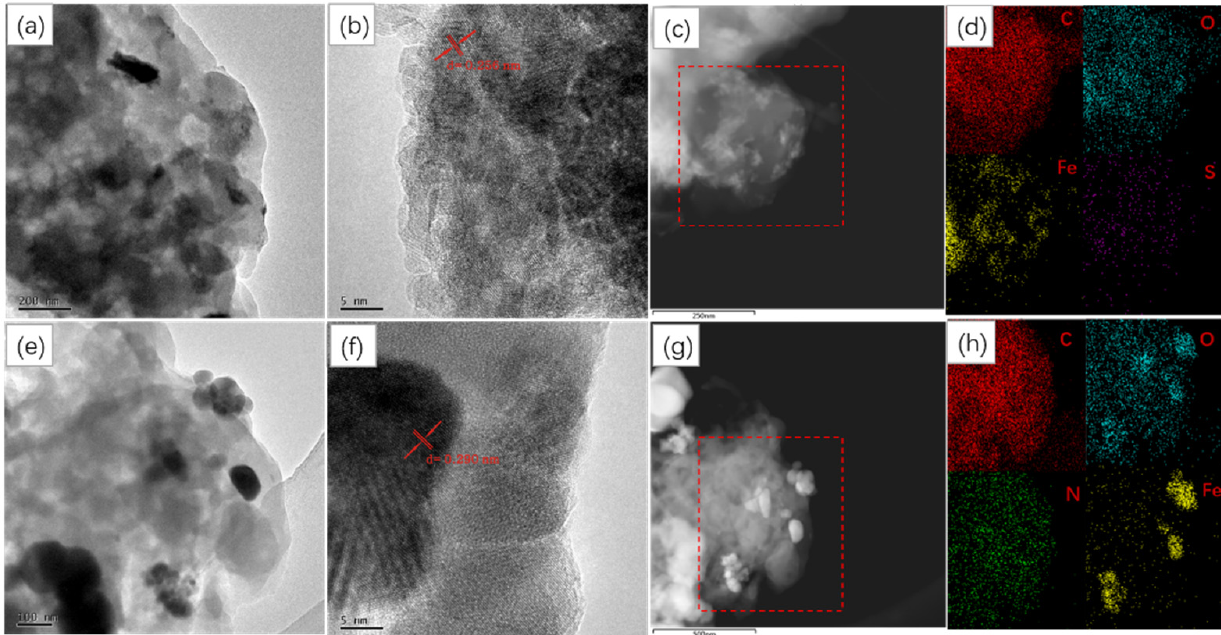
Figure 3. ( a ) TEM and ( b ) HRTEM of FeS/chitin composite film; ( c , d ) FeS/chitin composite film mapping; ( e ) TEM and ( f ) HRTEM of Fe 3 O 4 /chitin composite film; ( g , h ) Fe 3 O 4 /chitin composite film mapping. XRD data can also verified the FeS, Fe 3 O 4 fixation on the chitin matrix. The XRD spectra of the composite films and chitin were shown in Figure 4a. There were five peaks at 9.3 ◦ , 12.7 ◦ , 20.9 ◦ , 23.6 ◦ , 26.4 ◦ in the XRD spectra of chitin, corresponding to (020), (021), (120), (130) and (013) planes, confirming the typical antiparallel structural of